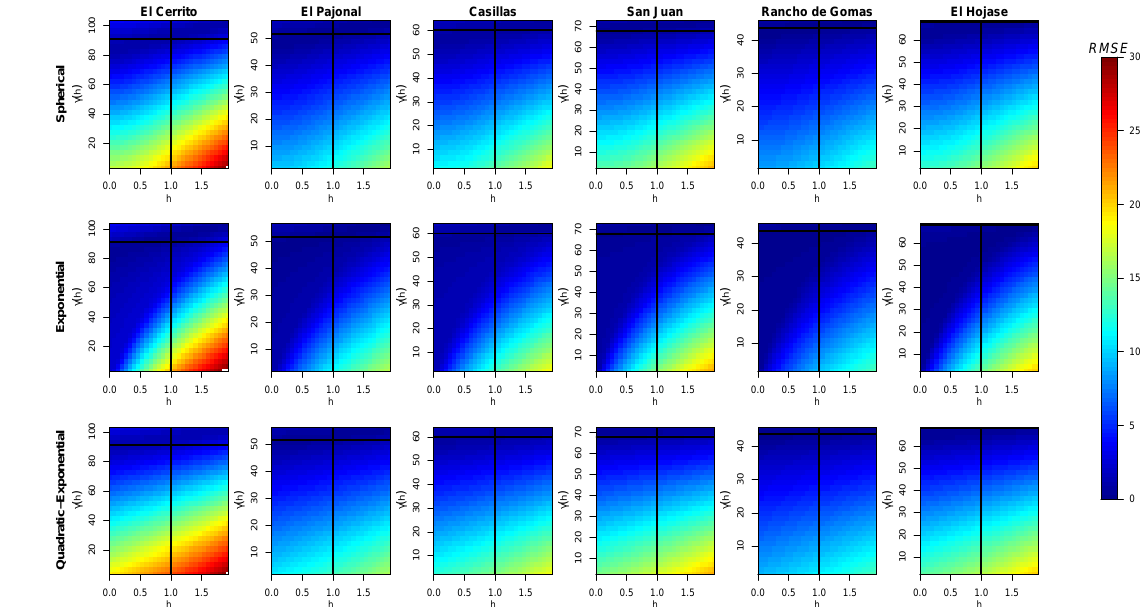
Figure 9. Obtained values of RMSE (color bar) for different pair of data ( r 0 , γ ( r 0 )) when fitting a curve for the variogram of each station with the three models and considering the nugget effect. The intersection of the black solid lines tags the real R 0 . The white areas (in the right-down corner) correspond to higher values than those shown on the color